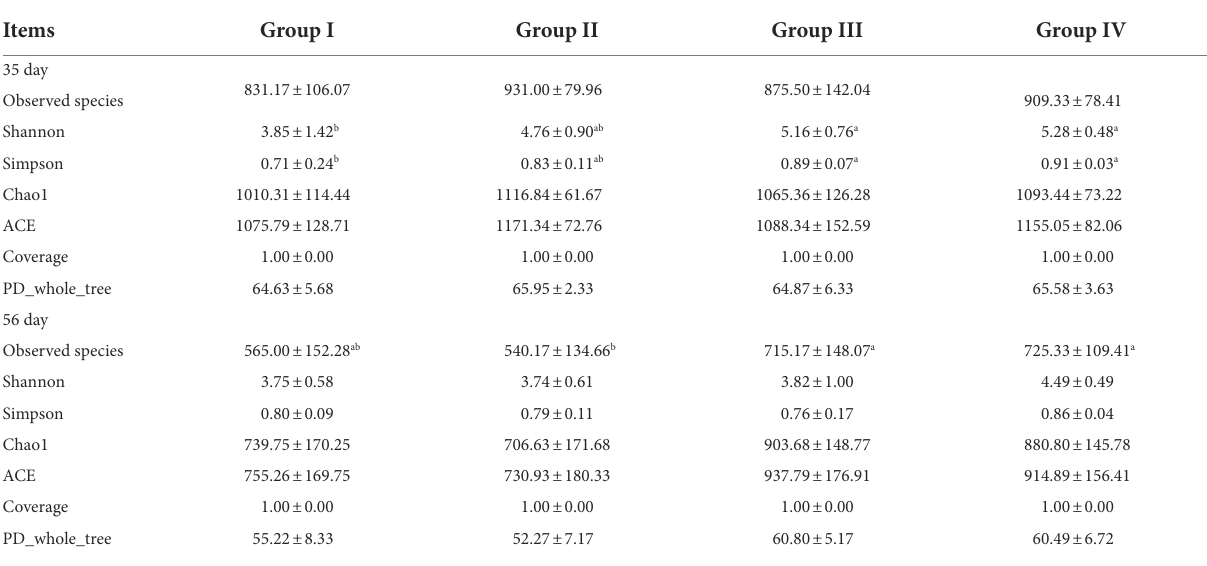
TABLE 7 Alpha diversity index of broiler cecal microbiome.